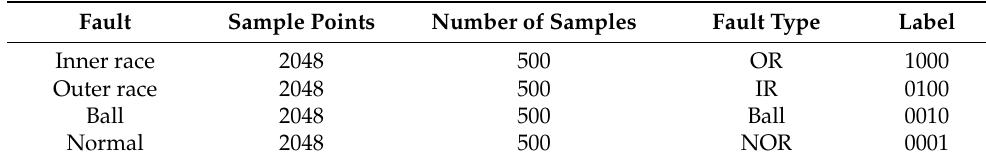
Table 5. Bearing status information (University of